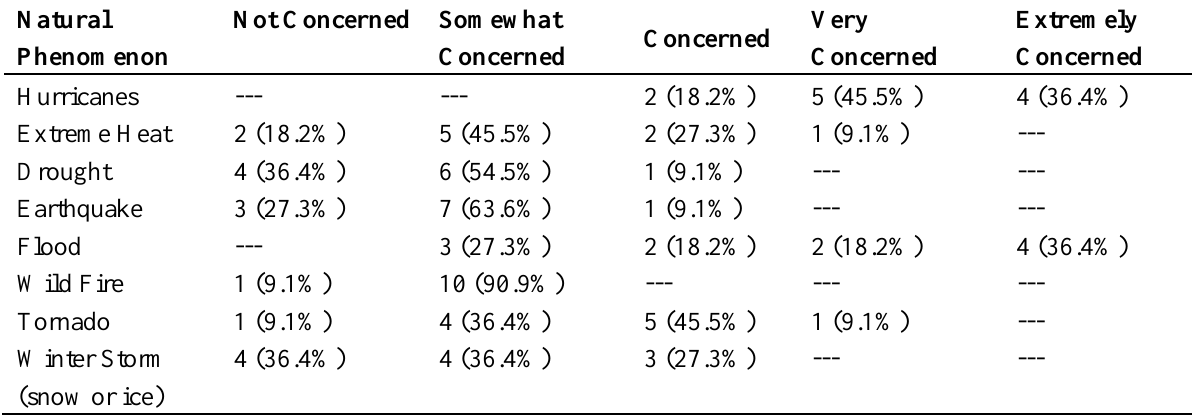
Table 4. Seasonal farmworkers’ degree of concern about specified natural disasters affecting their community. n = 11 Frequency (Valid